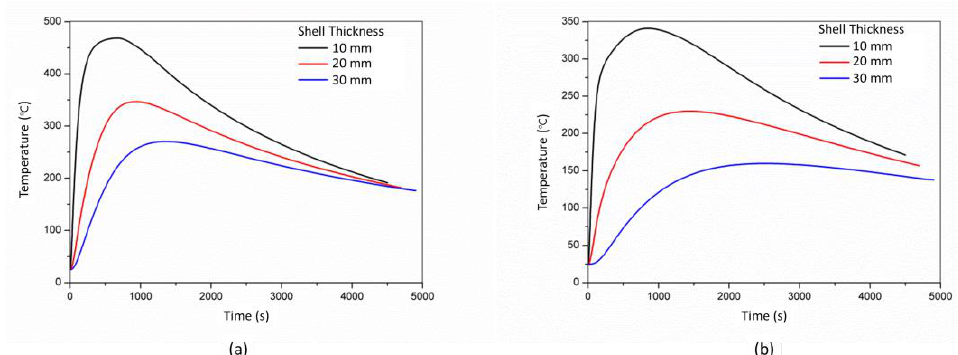
Figure 20. Comparison of cooling curves of (a) P3 and (b) P4 using the skeletal sand mold with a different shell thickness.